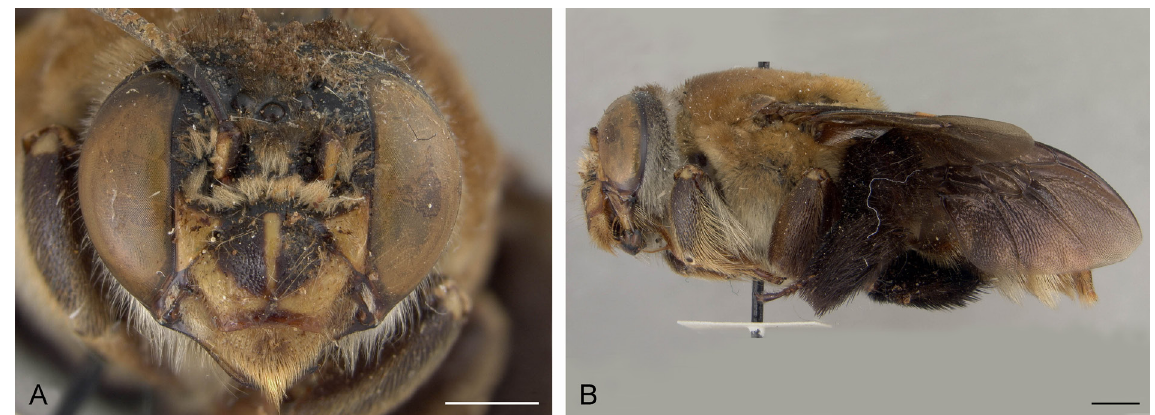
Fig. 27. Centris pachysoma Cockerell, 1919, holotype, ♀ (NMNH; USNM ENT 00534206). A . Frontal view. B . Habitus, lateral view. Scale bars: A = 1 mm; B = 2